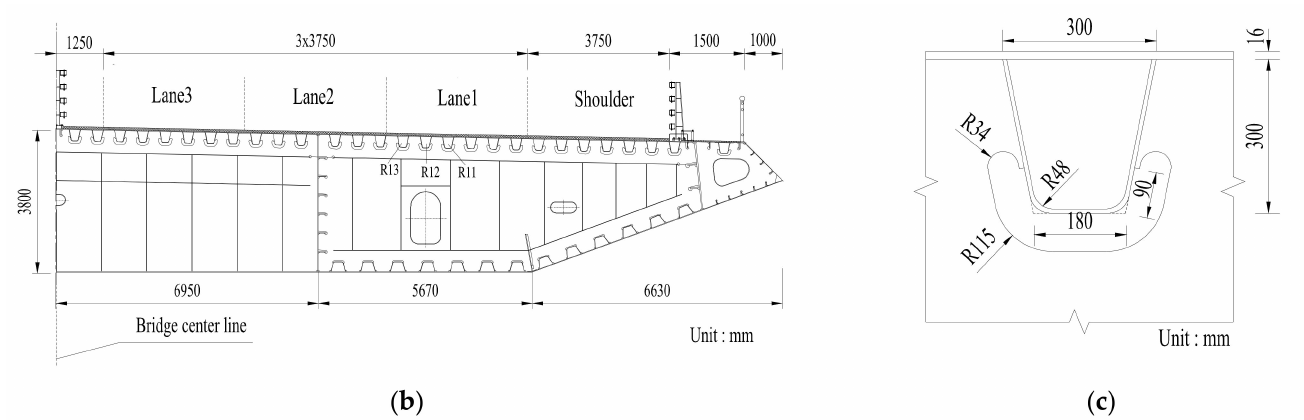
Figure 2. Bridge layout. ( a ) Bridge elevation; ( b ) Cross-section of steel box girder; ( c ) OSD.